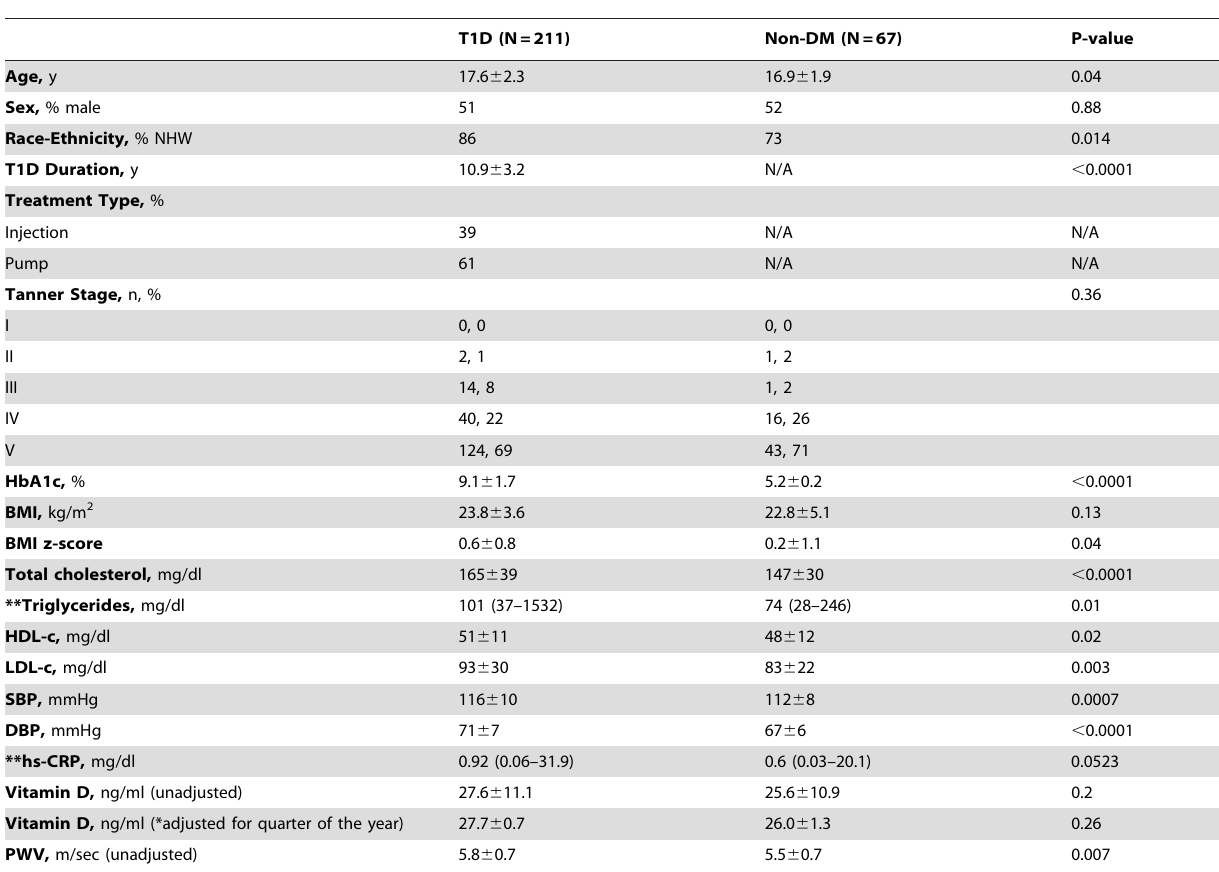
Table 1. Clinical characteristics of study populations.